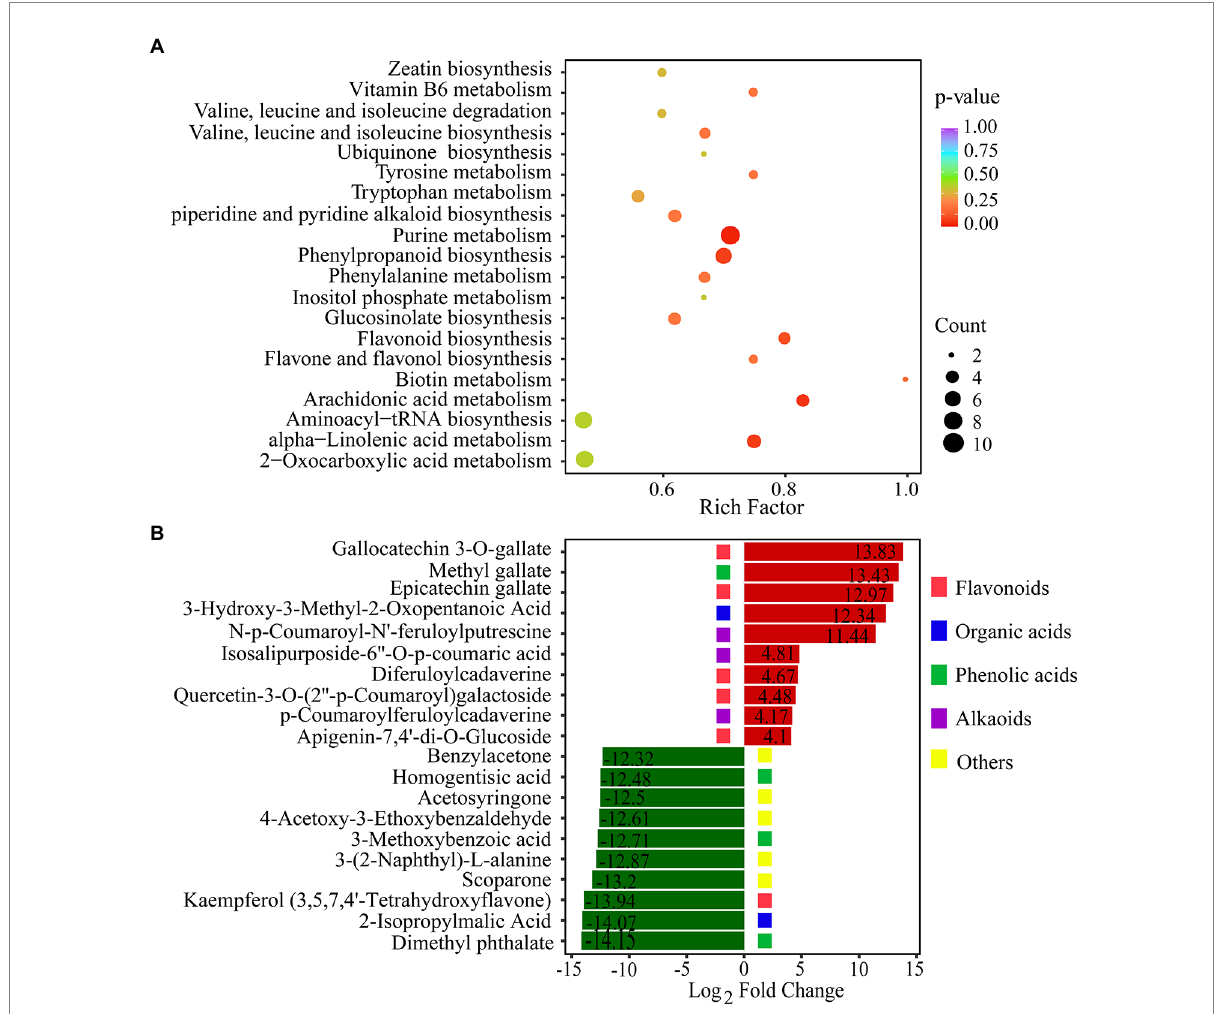
FIGURE 5 Statistical analysis of differentially changed metabolites (DCMs). (A) KEGG enrichment analysis of the DCMs between the PEG60h group vs. CG. Rich factor indicates the ratio of the DCMs amount to the total amount of annotated metabolites in the pathway. (B) The fold change of the top 20 significantly changed metabolites between the PEG60h group vs. CG. The numbers into the bars refer to log 2 (Fold